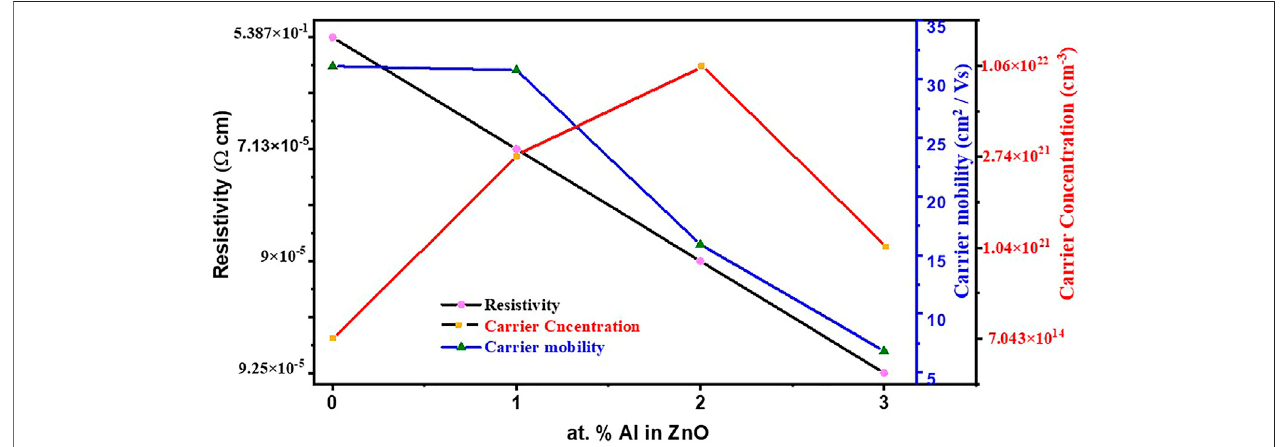
FIGURE 5 | Variation in resistivity, carrier mobility, and carrier concentration of ZnO fi lms with Al doping.